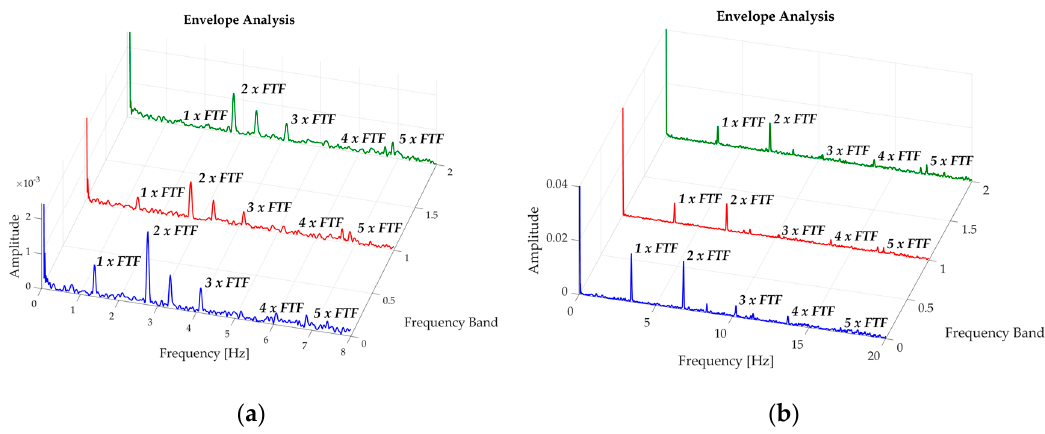
Figure 19. Envelope Analysis for a bearing with 5 damaged REs, filter band at: 1.8–6.1 × 10 3 Hz (blue) band, 6.1–9.8 × 10 3 Hz (red) and 9.8–12.8 × 10 3 Hz (green); for: ( a ) 200 rpm, and ( b ) 500 rpm.